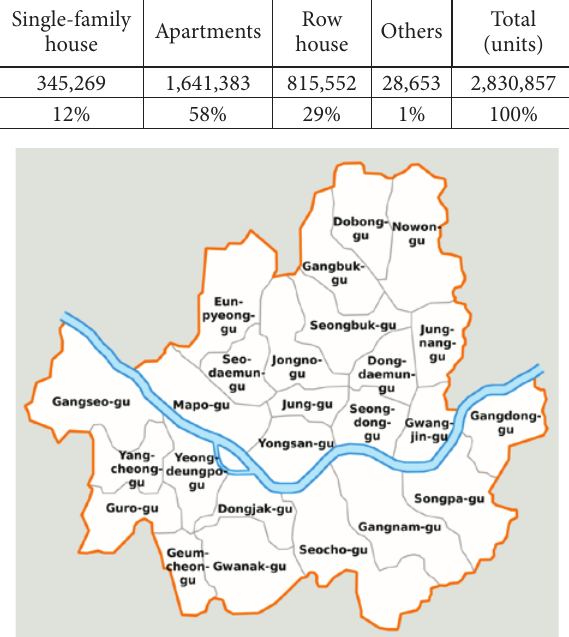
Figure 2. Administrative map of Seoul with 25 districts (source: Commons, 2012 (https://commons.wikimedia.org/wiki/Talk:Seoul)) Table 2. Descriptive statistics (11,075 units in 919 complexes)